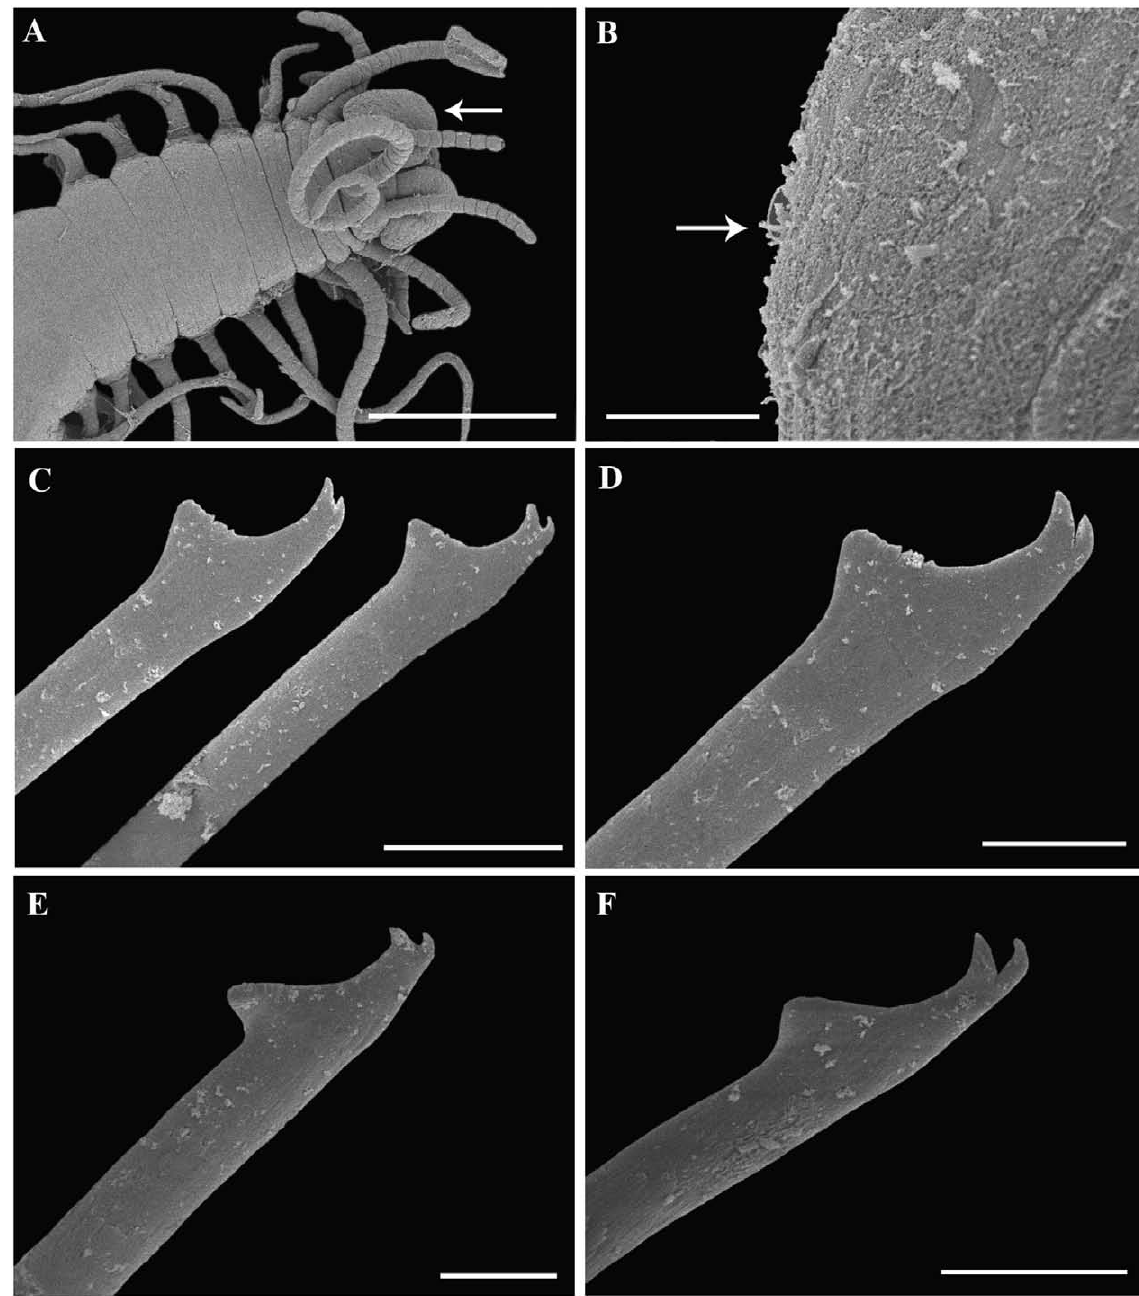
Fig . 12. – SEM micrographs of Haplosyllis gula . A, anterior end, dorsal view, arrow point on cilia. B, upper ventral side of palps, arrow points on cilia. C, mid-body chaetae. D, detail of long chaeta. E, posterior long chaeta. F, posterior short chaeta. Scale bars: A (300 m m), B-C (10 m m), D-F (5 m m). INV-ANE